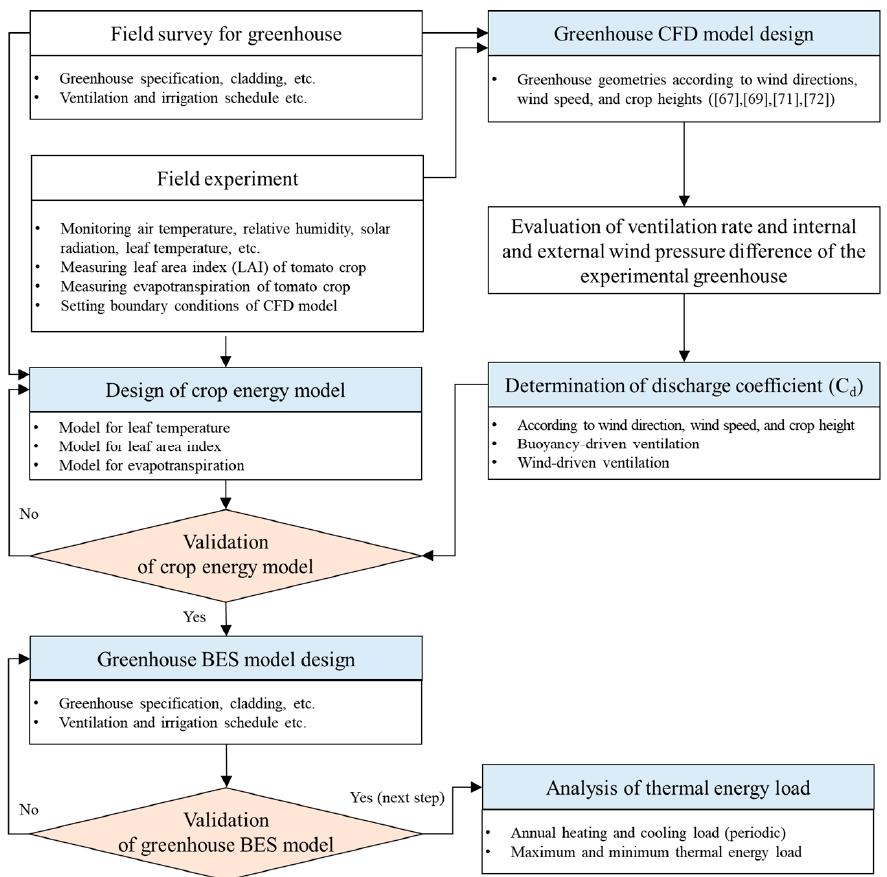
Figure 1. Research flow for analysing the thermal energy load of the experimental greenhouse.